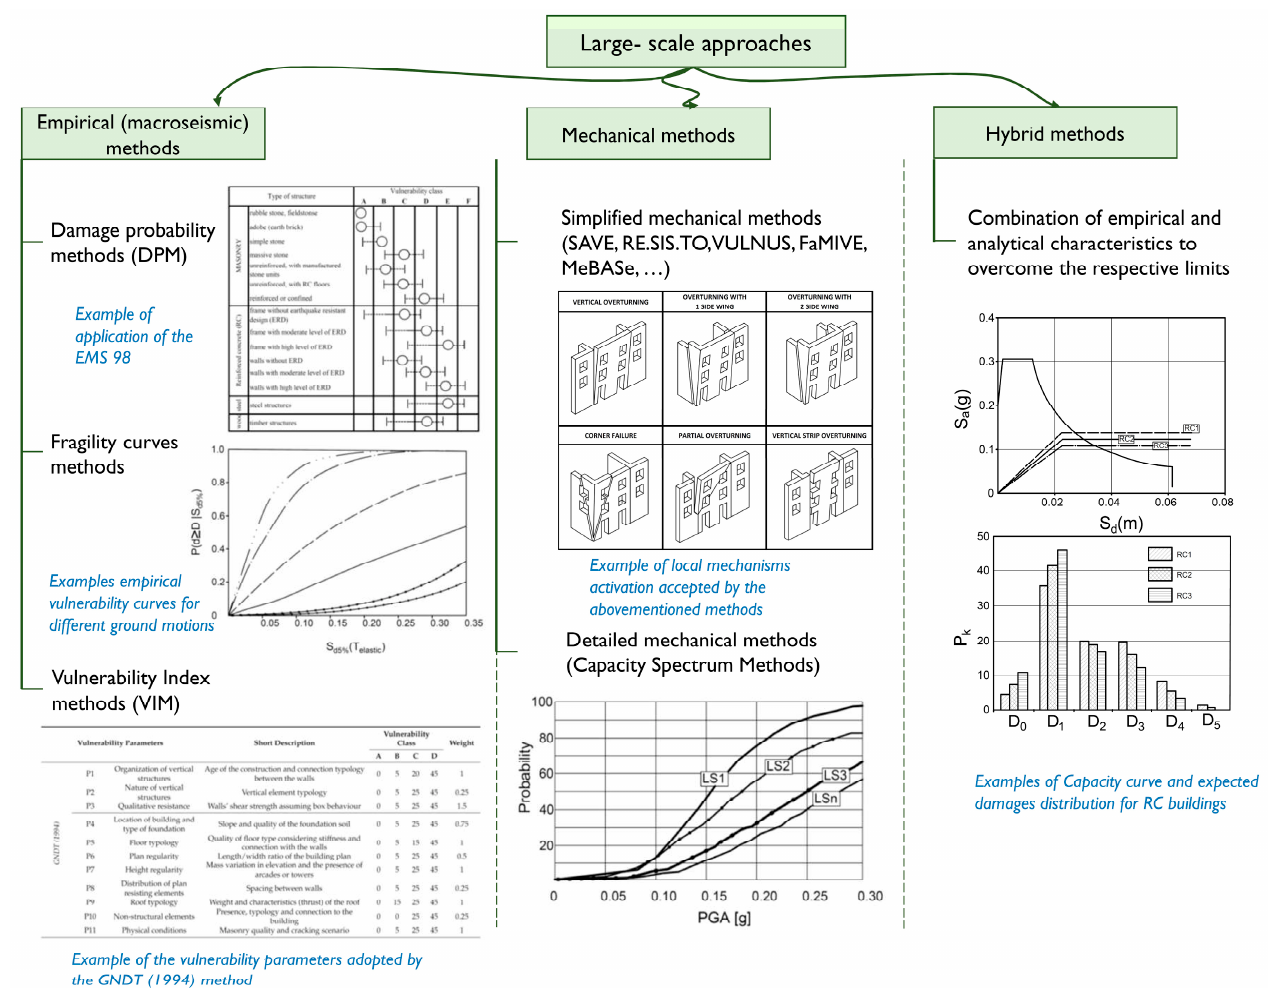
Figure 1. Categories of large-scale approaches (the figure is based on [10]).